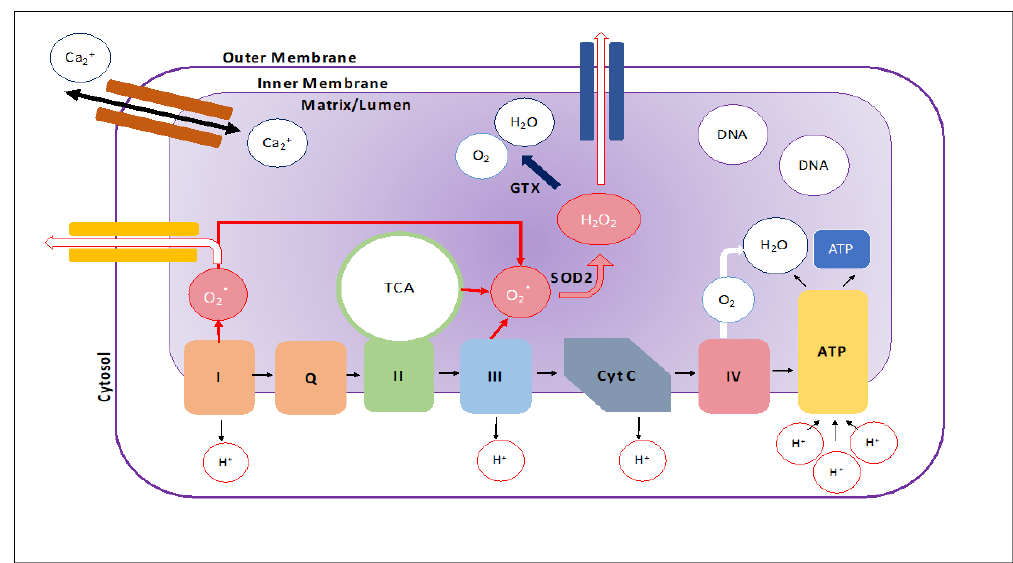
Figure 1. Mitochondrial structure. Schematic of the mitochondrion showing the electron transport chain, flow of ions, and generation reactive oxidative species. These reactive oxidative species can be reduced to hydrogen peroxide via the SOD2 enzyme and further broken down into H 2 O and O 2 by the GPX enzyme. However, the reduction process is not perfect and when under high stress, reactive oxidative species can leak out of the mitochondria. The mitochondria are also important regulators of intracellular calcium concentration.